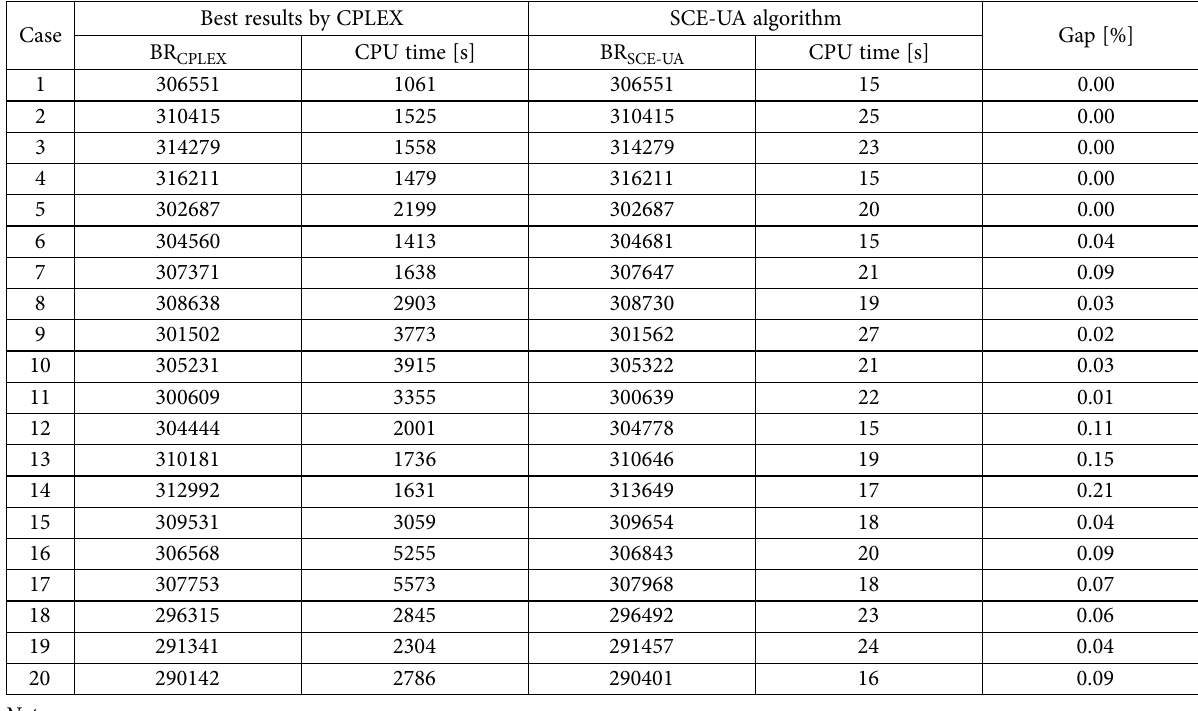
Table 2. Comparison of the optimal solution for the proposed solution method